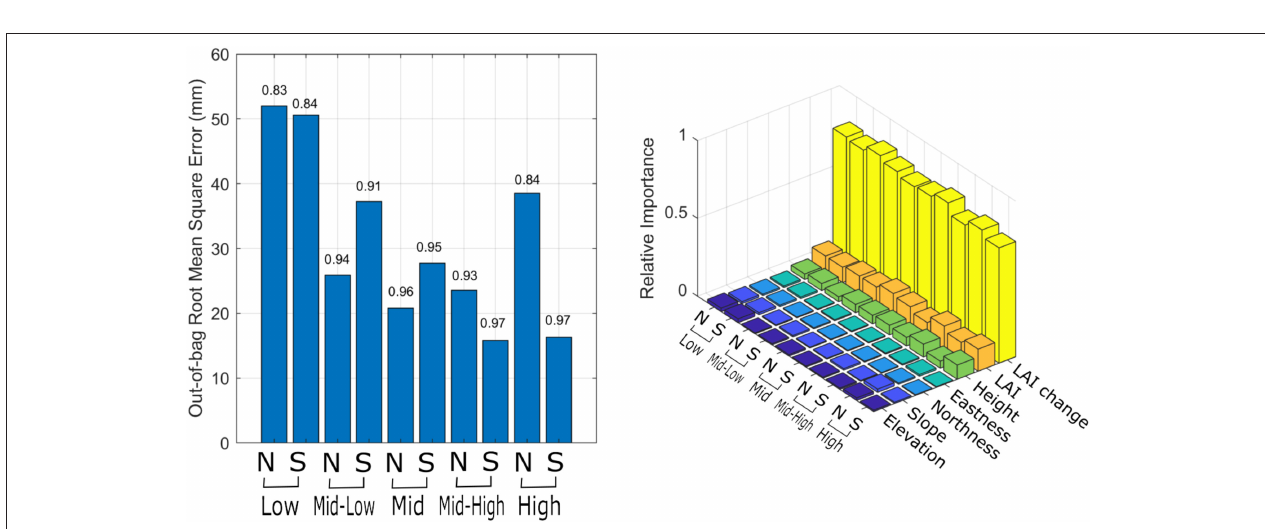
FIGURE 11 | Left panel: out-of-bag root mean square error (y-axis) and correlation (numbers on top of bars) for the Random Forest models at each Snow Zone. Right panel: relative importance factors of the predictor variables used in the Random Forest